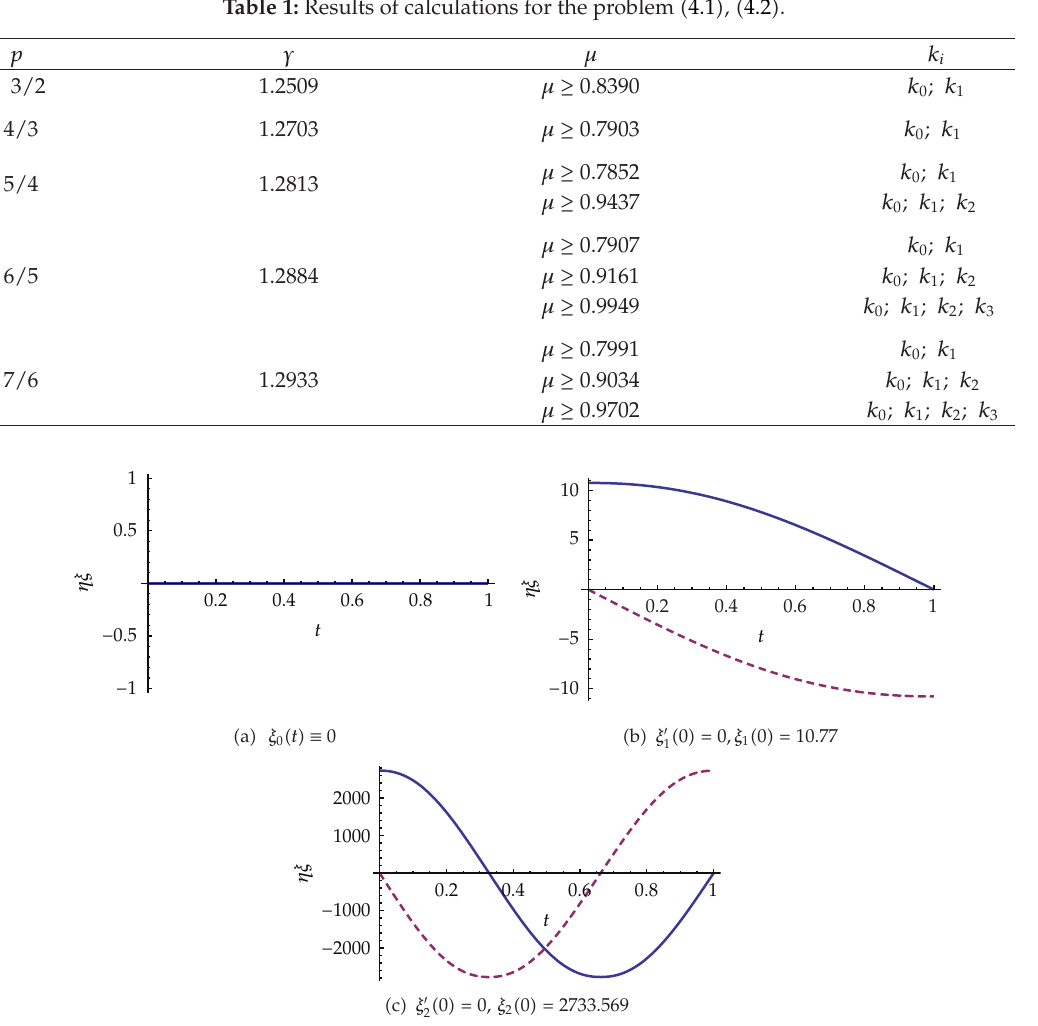
Figure 1: Di ff erent type solutions of the problem (cid:3) 4.25 (cid:4)